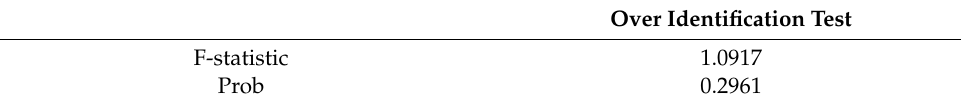
Table 12. Results of the over identification test.